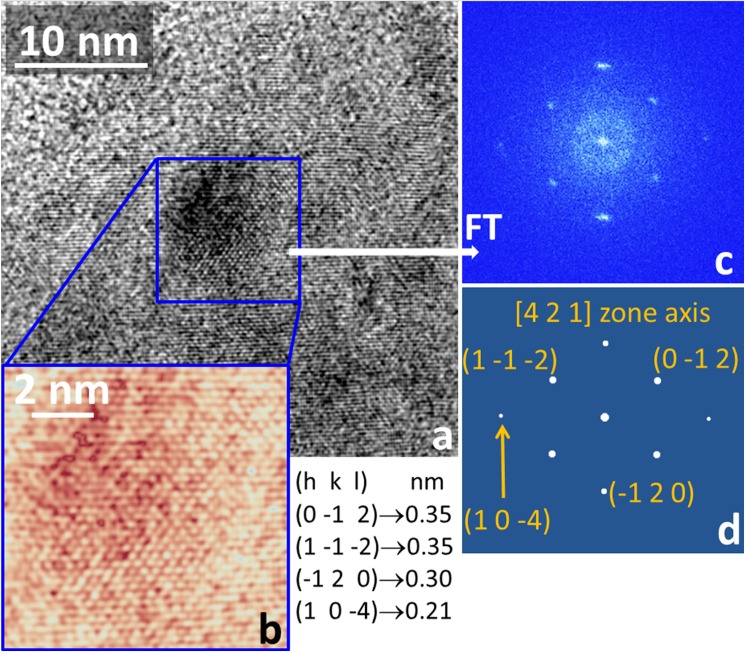
Representative results on the small dark particles.a) HRTEM image focused on one of the small and dark nanoparticles shown in Fig 3; b) zoom inside the red square of panel a) (false color output); c) diffractogram relevant to the zoomed area in panel b); d) simulation, with the Miller indexes associated to some spots and the corresponding lattice spacing. Simulations show that the diffractogram of panel c) is compatible with the ferrihydrate in the [4 2 1] zone axis.